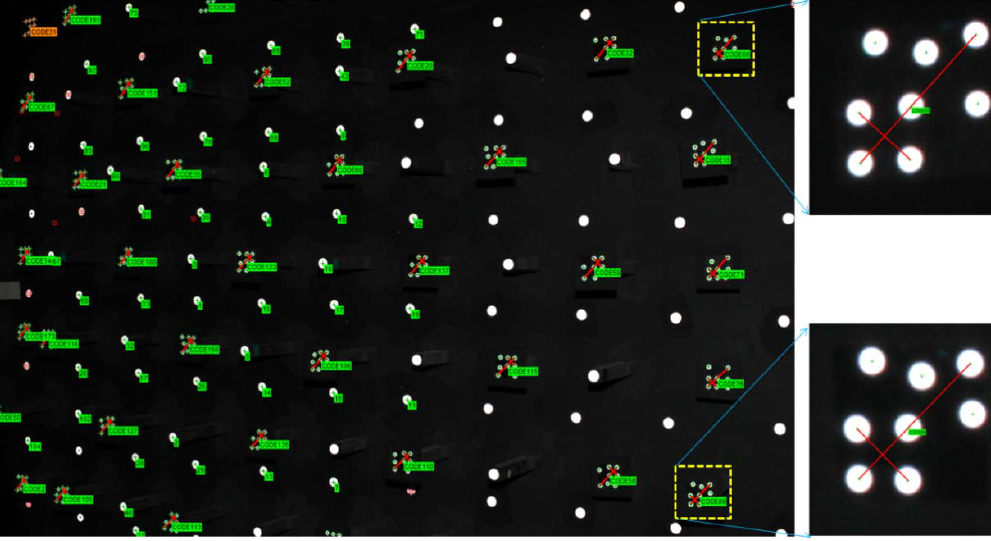
Figure 3. A sample image for camera calibration and two enlarged code targets.